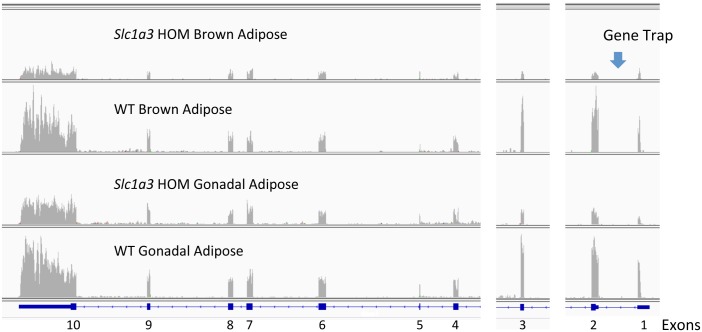
Reads for Slc1a3 TRAP mutant and wildtype (WT) control interscapular brown adipose tissue and gonadal adipose mapping to Slc1a3 genomic sequence.In both types of adipose tissue, reads from the mutant libraries map to each exon of the Slc1a3 gene. However, the number of reads is reduced relative to WT. This is a TRAP mutant with the gene trap cassette placed 5’ to exon 2. We found no reads for Slc1a3 in libraries created from WT or HOM liver, and very low reads in abdominal muscle, therefore the graphs for those tissues are not presented. This visualization of Tophat2 mapping of RNA-seq read counts to the mm10 mouse reference genome sequence used the IGV reader. Exon segments are cut and pasted into position to show alignment of the reads against the genome reference sequence. At the bottom of each panel is a cartoon of the exons and introns with intronic arrows indicating the direction of transcription. Each panel is labeled with genotype and tissue. The read histograms, or pileups, show the numbers of reads at each nucleotide for each library. The Y-axis read count range of each graph for HOM and WT for the same tissue is adjusted to account for differences in total library reads. Therefore, the height of the bars for each HOM and WT tissue pair indicate the relative abundance of reads.